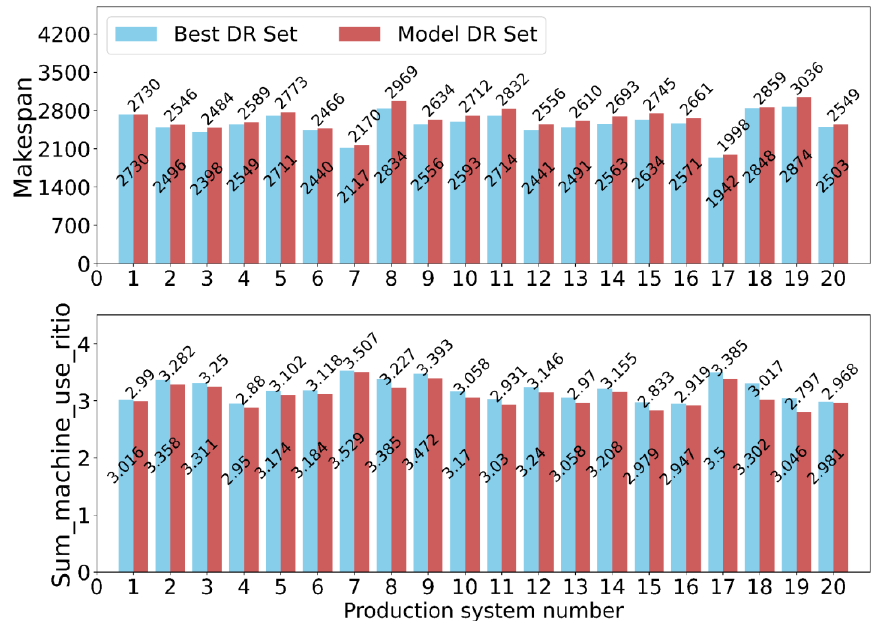
Figure 16. Low job heterogeneity and a low manufacturing system load rate.